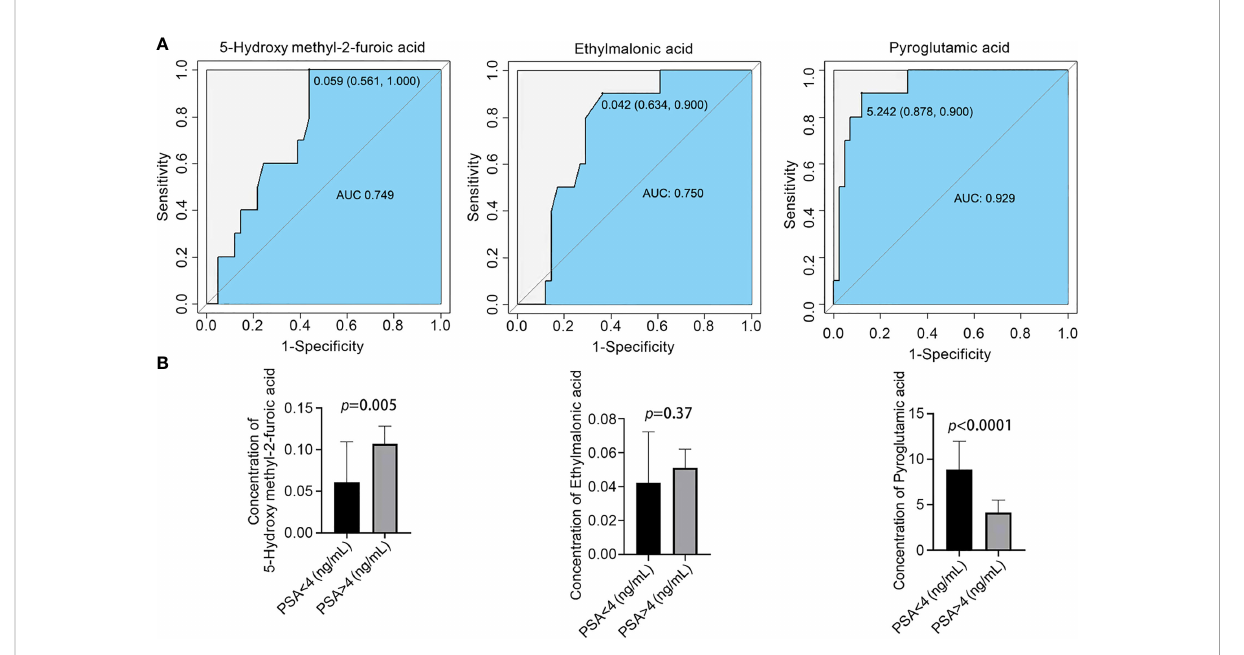
FIGURE 4 Comparison of the contents of organic acid metabolites in the serum of different prostate cancer groups and ROC curve analysis. (A) ROC curve analysis of 5-hydroxymethyl-2-furoic acid, ethylmalonic acid, and pyroglutamic acid for distinguishing prostate cancer patients with PSA < 4.0 ng/mL and PSA > 4.0 ng/mL. (B) Comparison of 5-hydroxymethyl-2-furoic acid, ethylmalonic acid, and pyroglutamic acid in the serum of prostate cancer patients with PSA < 4.0 ng/mL and PSA > 4.0